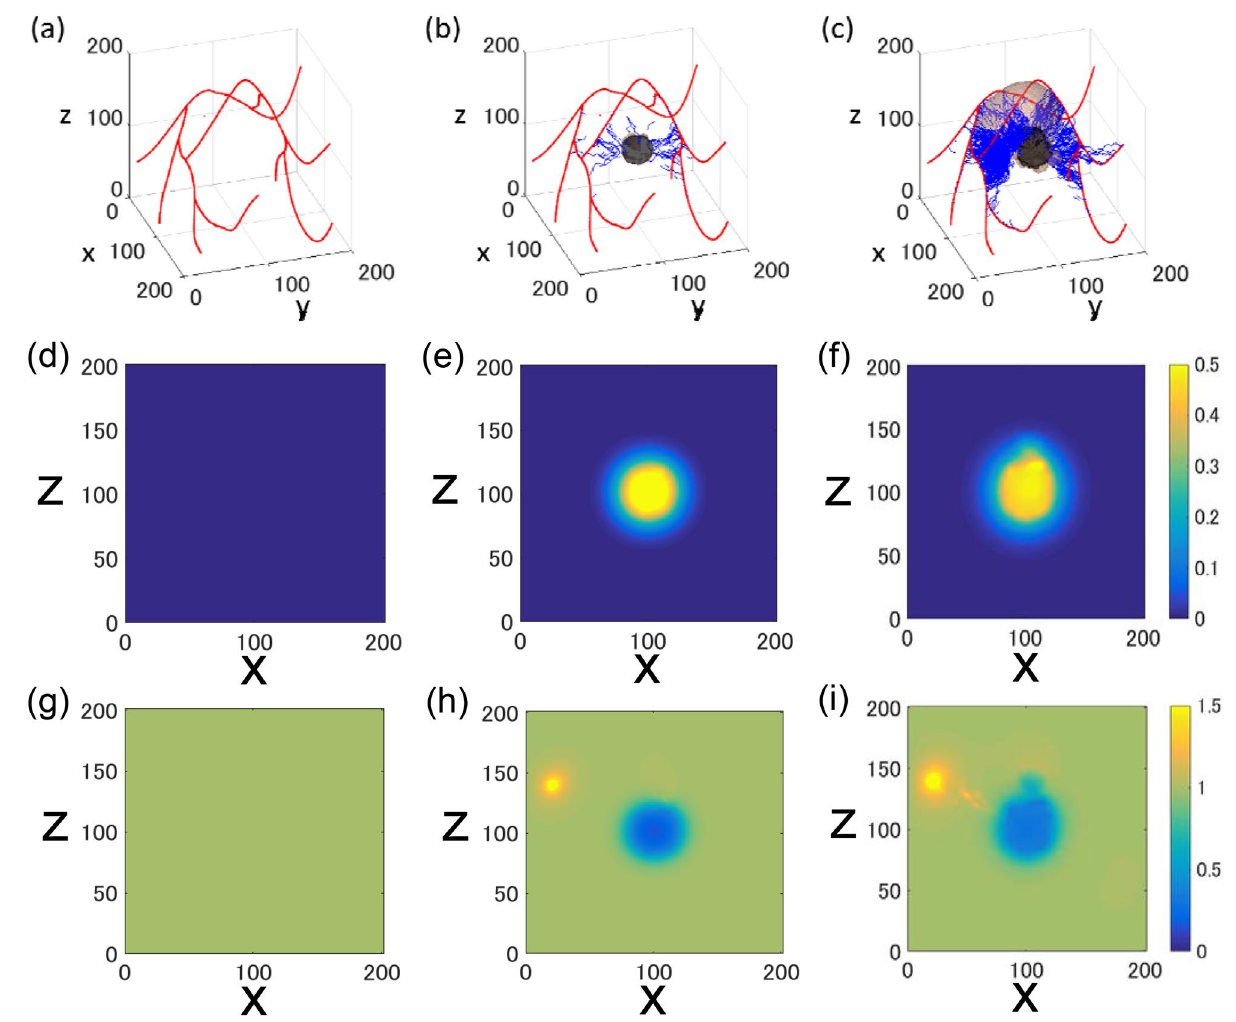
Figure 2. Snapshot of the spatial distribution of blood vessels, tumours, and related factors. Snapshots on day 0 ( a , d , and g ), 40 ( b , e , and h ), and 60 ( c , f , and i ). Panels ( a – c ) show vascular and tumour status. Red and blue curves show existing blood vessels and the newly sprouted vessels, respectively. Initially, we placed five tumours in the central part of the virtual space; ( d – f ) [VEGF] at y = 100. VEGF was secreted by tumour cells in the hypoxic state. Additionally, VEGF was not present in the initial phase; ( g - i ) Time evolution of [O 2 ] at y = 100. Oxygen was uniformly present throughout the initial phase. Oxygen was secreted by blood vessels and consumed by tumour